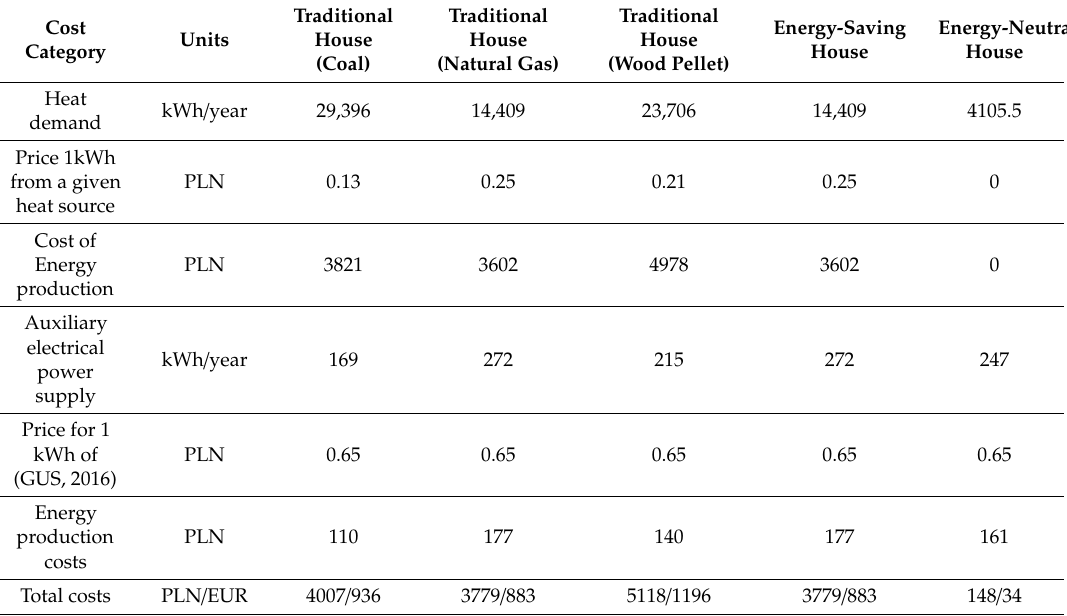
Table A2. Energy generation costs for the domestic water heating